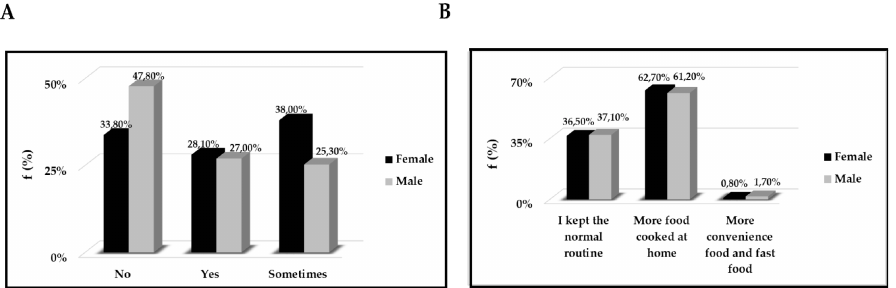
Figure 2. ( A ) Dietary behaviours. On the y-axis we reported the frequency as a percentage (%) respect to stratification by gender, and on the x-axis if the amount of food consumed during the quarantine had increased, remained unchanged or decreased ( B ) Quality of food used. On the y-axis we reported the frequency as a percentage (%) respect to stratification by gender, and on the x-axis the types of food used during the quarantine.